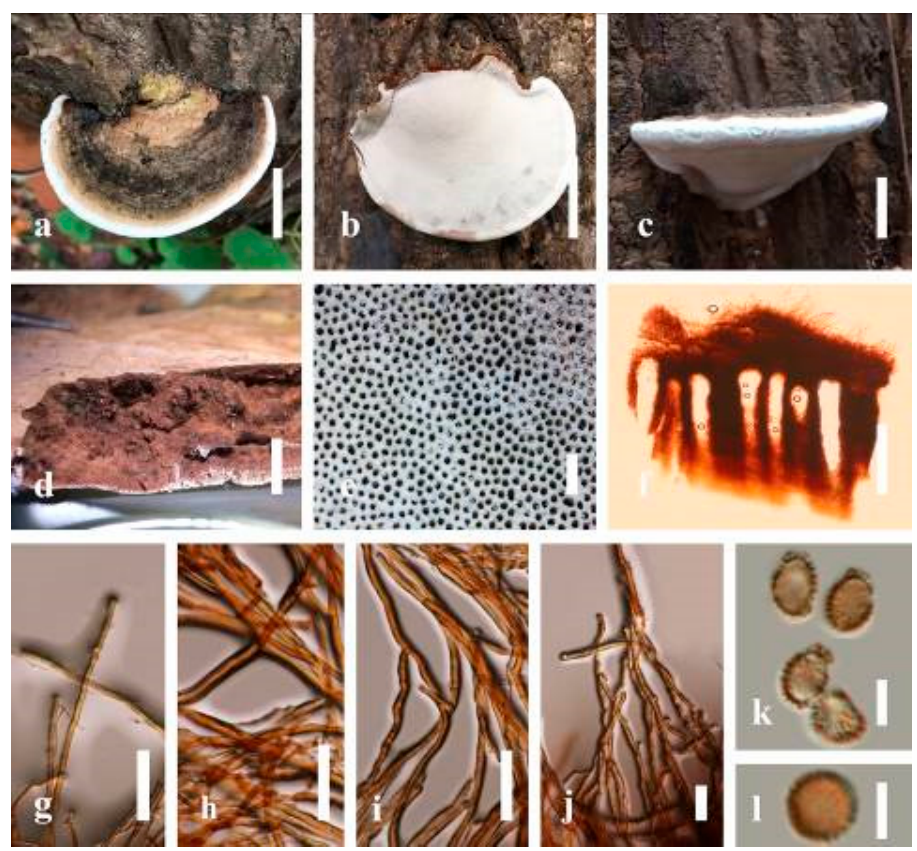
Figure 25. Ganoderma gibbosum (MFLU 19 ‐ 2176): ( a ) the upper surface of mature basidiomes; ( b ) the lower surface of mature basidiomes; ( c ) margin; ( d ) context morphology; ( e ) pore characteristics; ( f ) tube layers; ( g ) generative hyphae of context in Melzer’s reagent; ( h , i ) skeletal and binding hyphae of context in Melzer’s reagent; ( j ) hyphae and clamp connections of context in Melzer’s reagent; ( k , l ) basidiospores in Melzer’s reagent. Scale bars: ( a – c ) = 2 cm, ( d ) = 1 cm, ( e ) = 500 μ m, ( f ) = 200 μ m, ( g – i , k , l ,) = 5 μ m, ( j ) = 20 μ m. (Figure 26) Facesoffungi number: FoF 06250 Description: Basidiomes annual or perennial, sub ‐ reniform to reniform, stipitate. Pi ‐